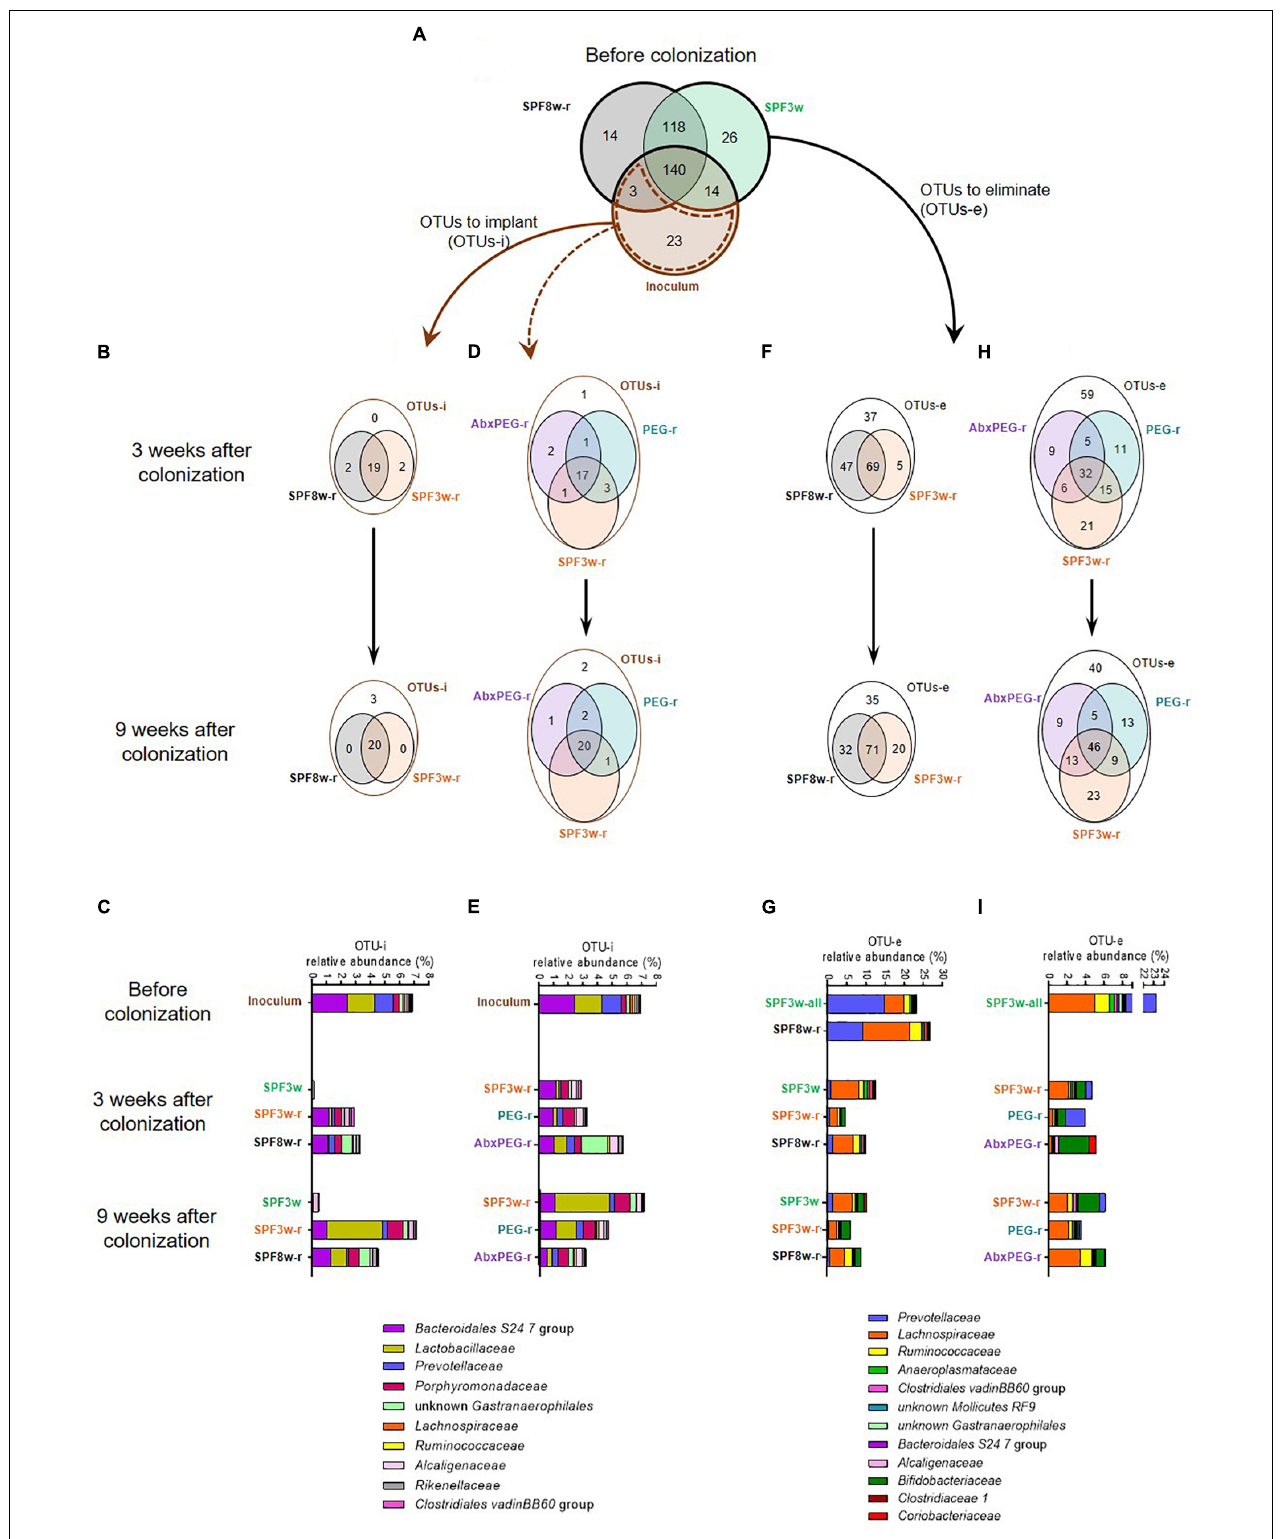
FIGURE 2 | Age and pre-treatment influence the number and relative abundance of OTUs that do or do not successfully colonize recipient mice and OTUs that are or are not successfully eliminated. (A) Venn diagram representing the overlap of OTUs in the inoculum and in 3 and 8 weeks old SPF mice before the fecal